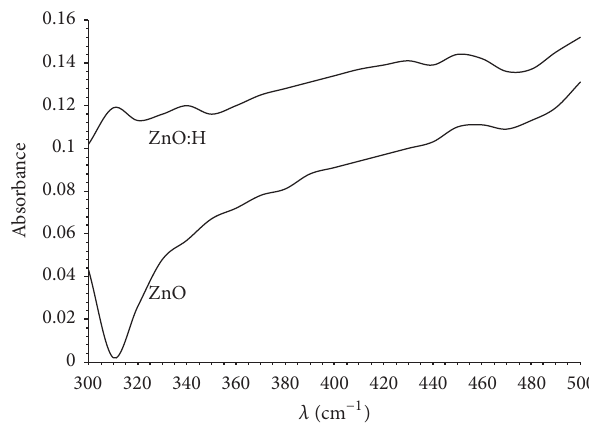
Figure 5: UV-Vis absorption spectra of ZnO and ZnO:H as a function of